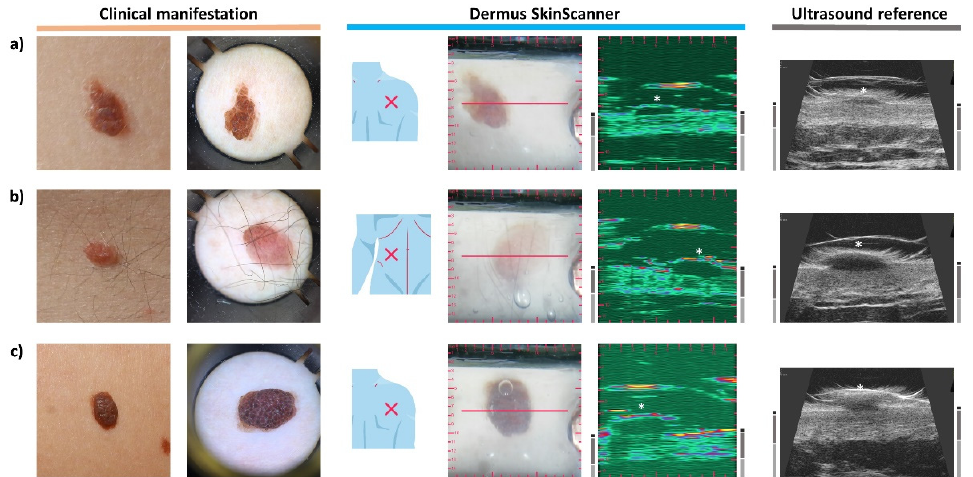
Figure 8. Examination images of naevi (see Figure 2 for figure layout and marking information). ( a )